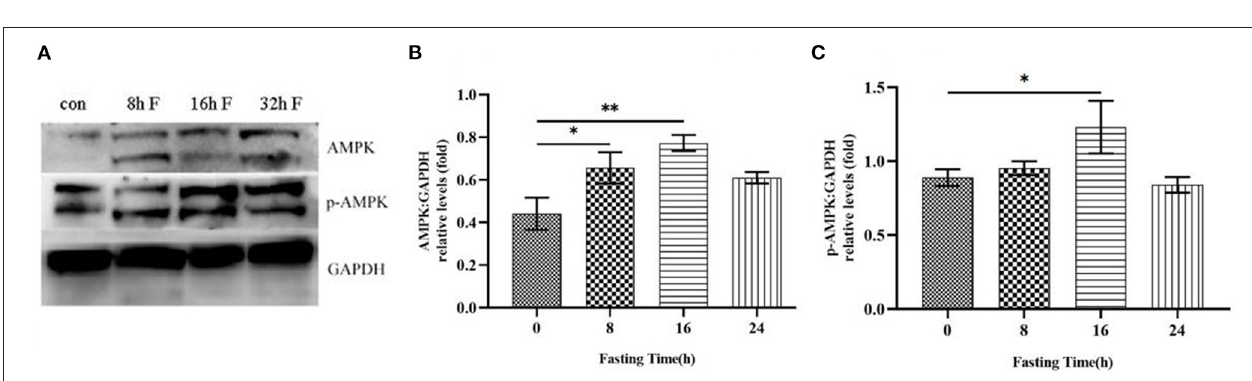
FIGURE 4 | Effects of fasting on the total protein level and phosphorylation level of AMPK in HFD mice. (A) Western blot analysis was performed to show the changes of AMPK protein level and phosphorylation level in HFD mice after different time of fasting. (B) Histogram plotted by the grayscale values of AMPK relative to Gapdh. (C) Histogram plotted by the grayscale values of p-AMPK relative to Gapdh. * P < 0.05, ** P <